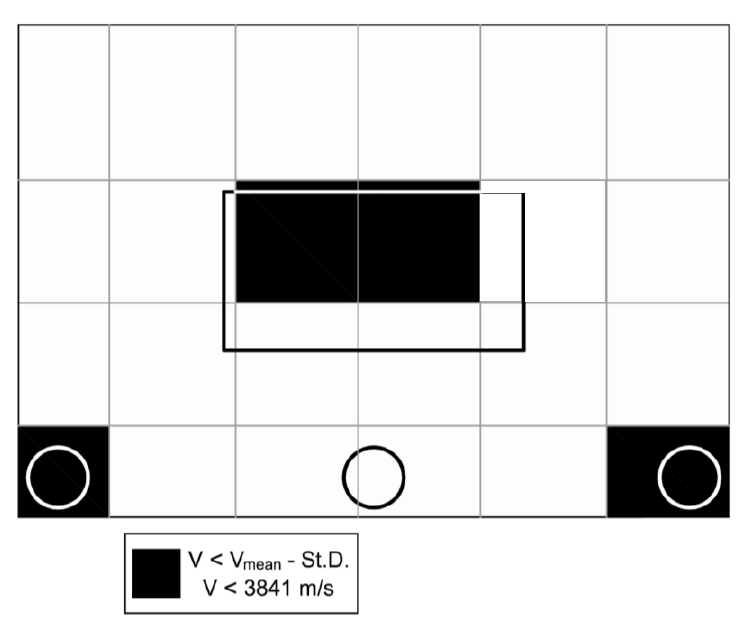
Figure 11. Map 9: Grid D. Defective areas.